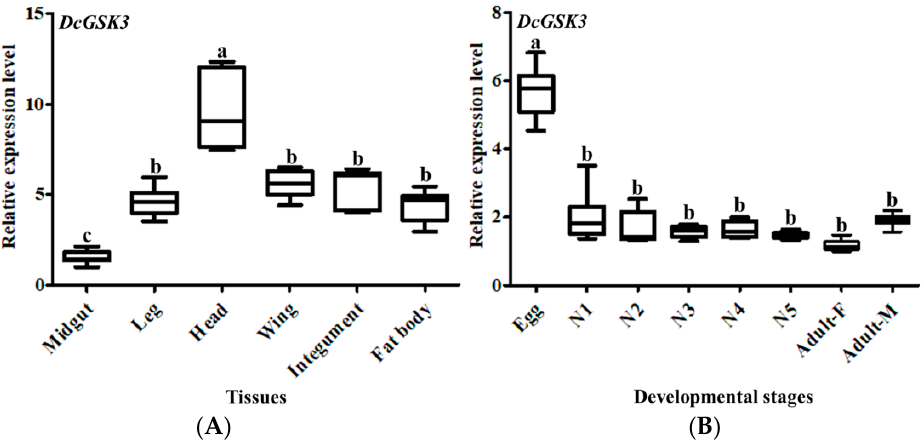
Figure 3. The relative expression levels analysis of DcGSK3 in different tissues ( A ) and different developmental stages ( B ). Data were normalized using glyceraldehyde-3-phosphate dehydrogenase ( GAPDH ) and are represented as the means ± standard errors of the means from three independent experiments. Different lowercase letters indicate the significant differences, for example, a, b and c ( p < 0.05).